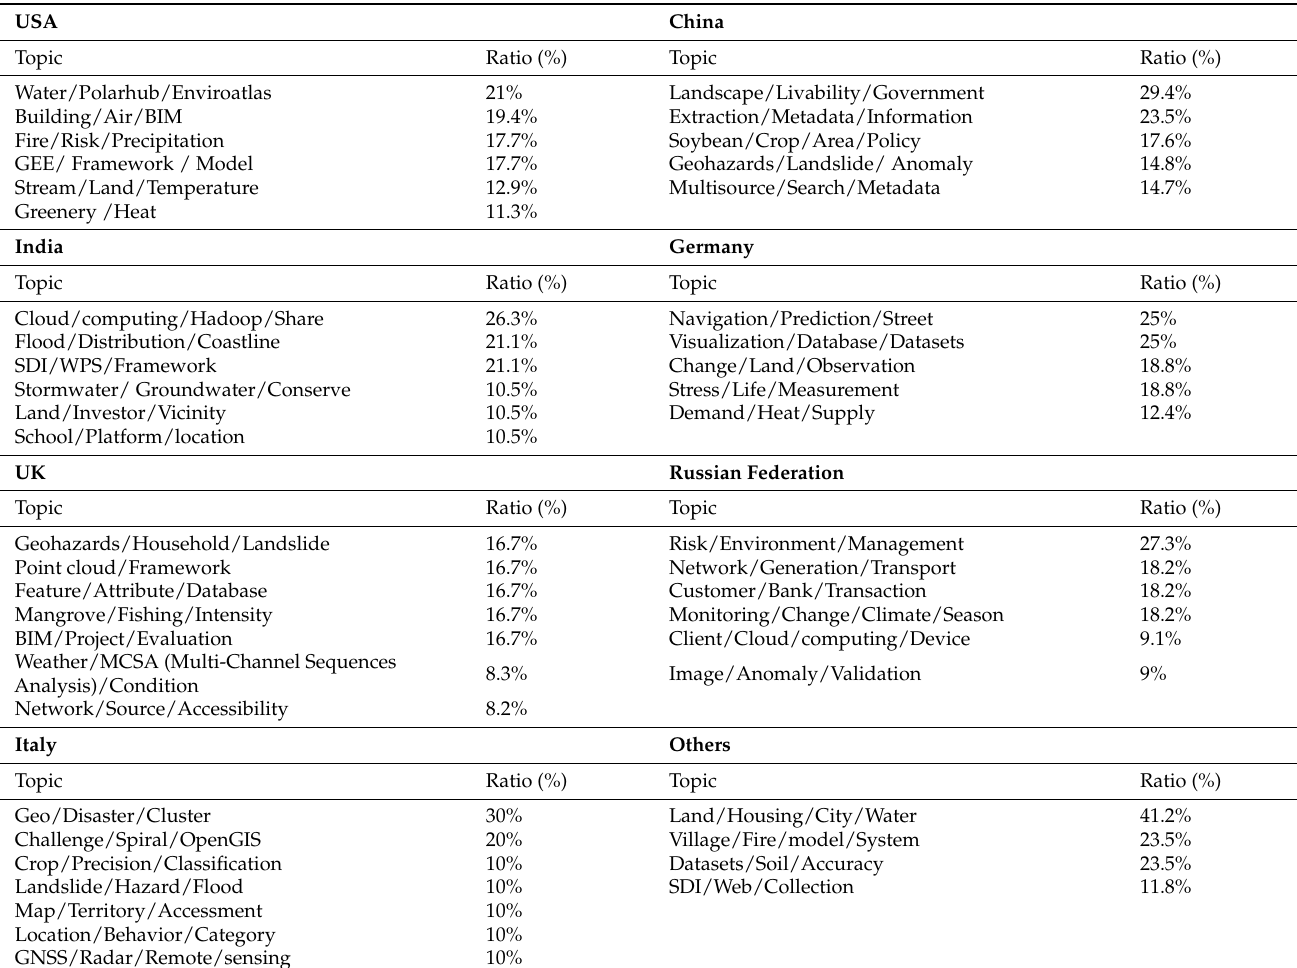
Table 1. The topic analysis results based on Bert_LSA model, and the percentage indicates the proportion of the country in all